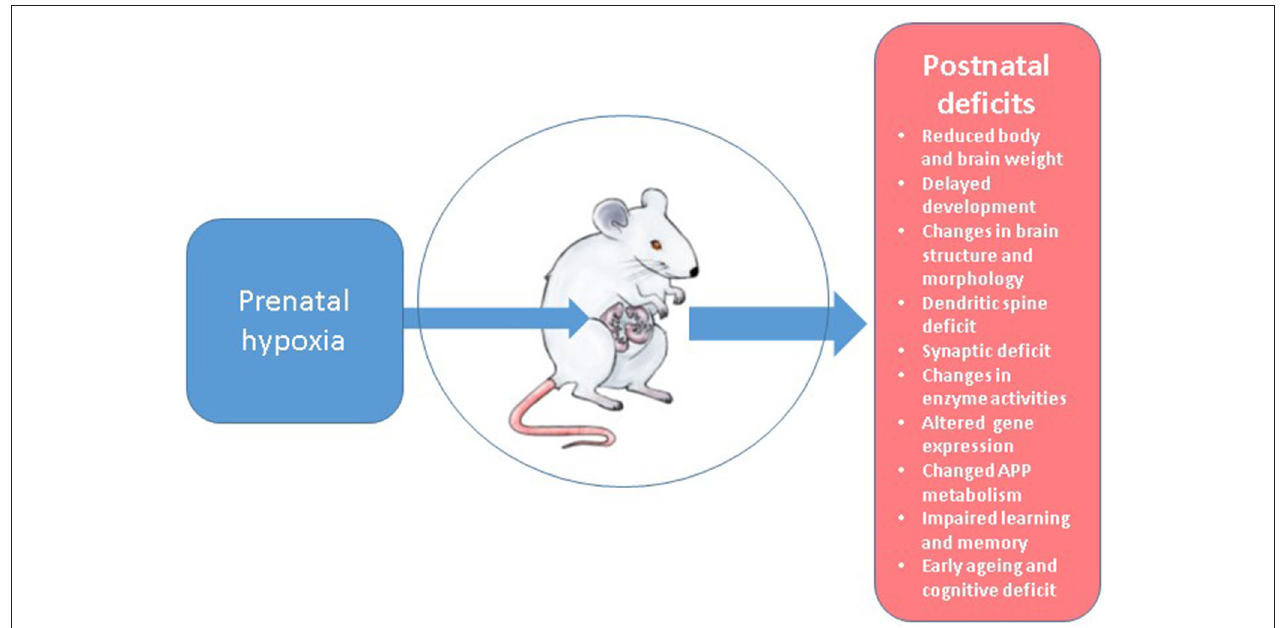
FIGURE 2 | Postnatal deficits observed in the rat model of prenatal